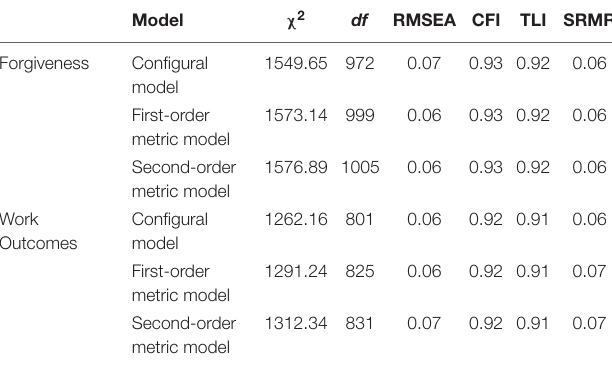
TABLE 1 | Configural and metric invariance